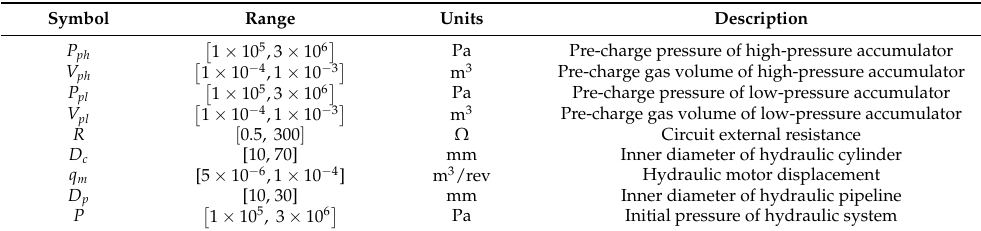
Table 3. Parameter description and the corresponding design space in the Morris method.